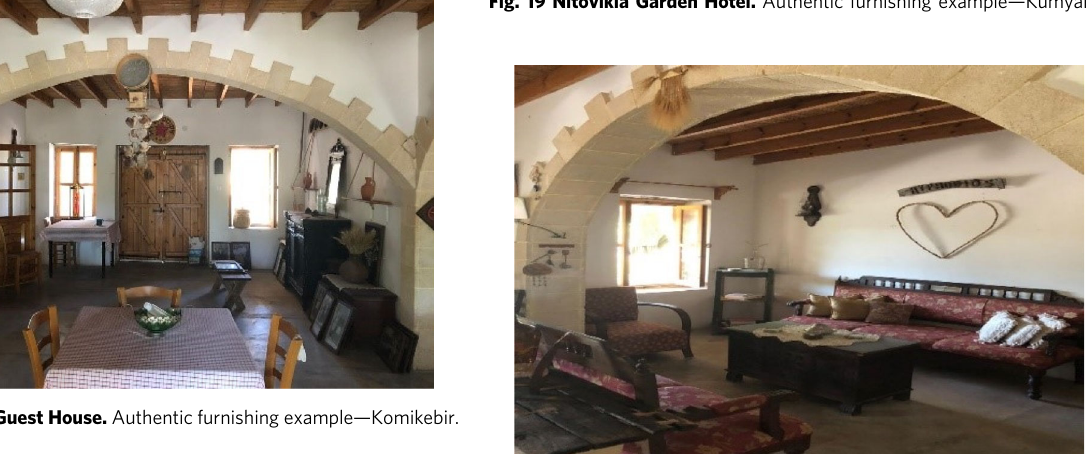
Fig. 19 Nitovikla Garden Hotel. Authentic furnishing example — Kumyalik.